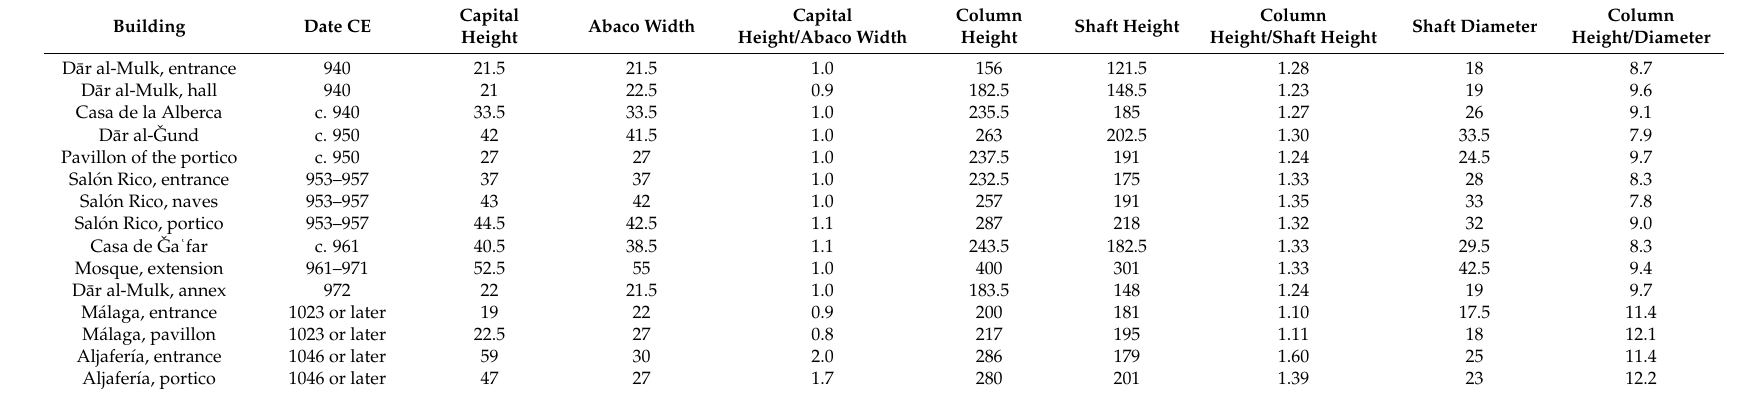
Table 1. Measurements and proportions of columns of the 10th and 11th century.